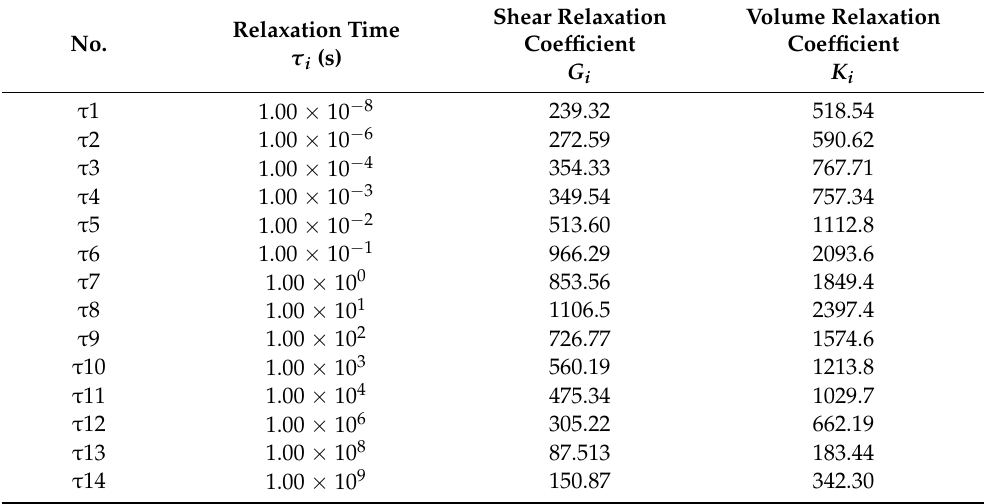
Table 3. Viscoelastic material parameters of epoxy molding compound.